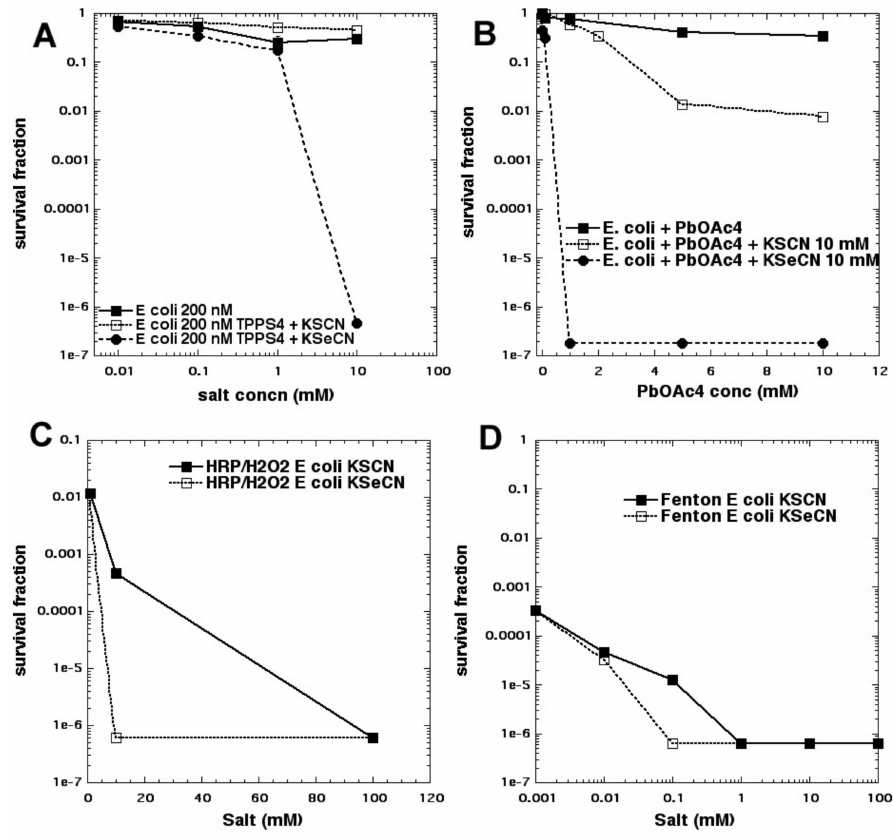
Figure 15. Comparison of thiocyanate and selenocyanate for potentiation of four different oxidative techniques against E. coli . ( A ) aPDI with TPPS4; ( B ) lead tetraacetate; ( C ) horseradish peroxidase and hydrogen peroxide; ( D ) Fenton reagent (Fe 2+ + H 2 O 2 ). Figure adapted from data contained in